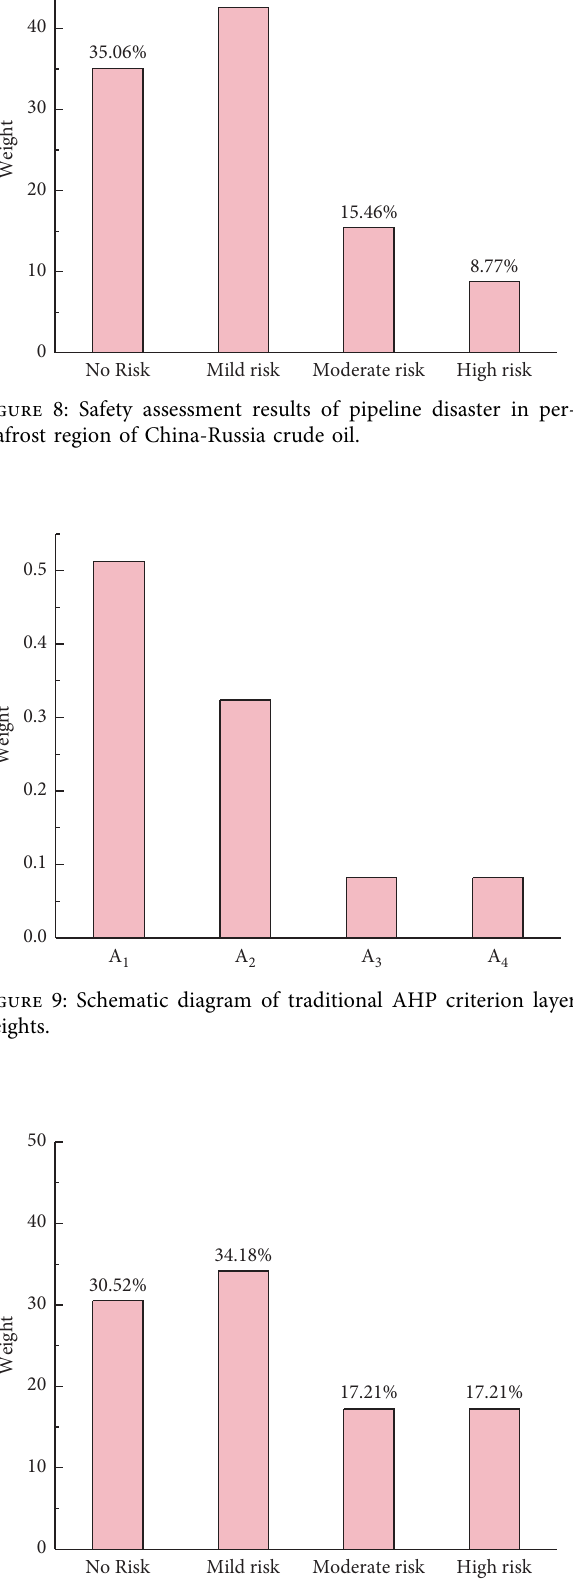
Figure 10: Safety evaluation results of traditional